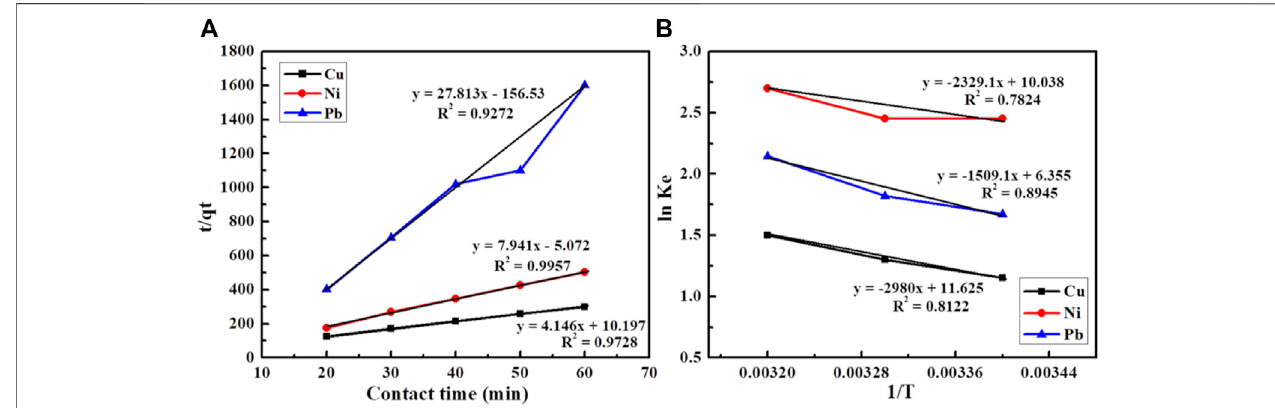
FIGURE 7 | (A) Adsorption kinetics of Cu, Ni, and Pb on the PANI-WH composite and (B) adsorption thermodynamics of Cu, Pb, and Ni on the PANI-WH composite.